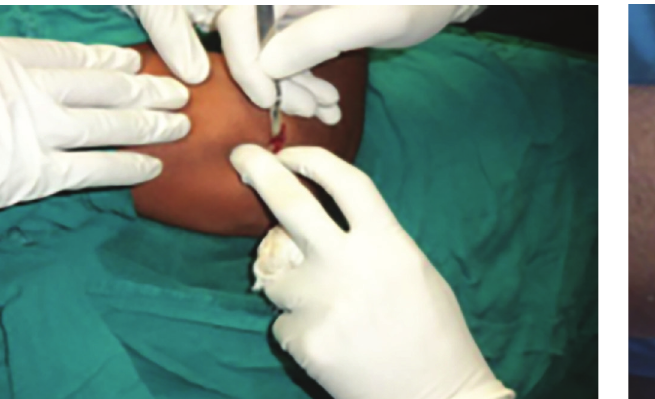
Figure 3 - Release of common extensor origin